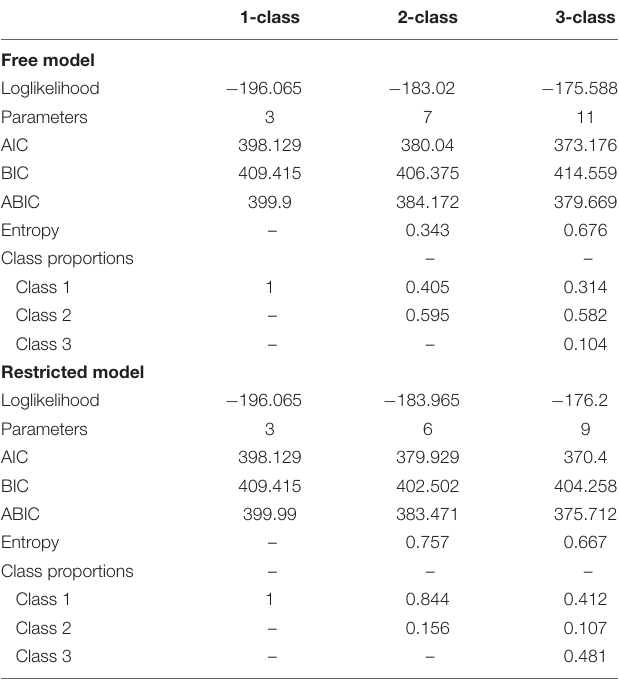
TABLE 7 | Fit indices for free and restricted models of data-application example.